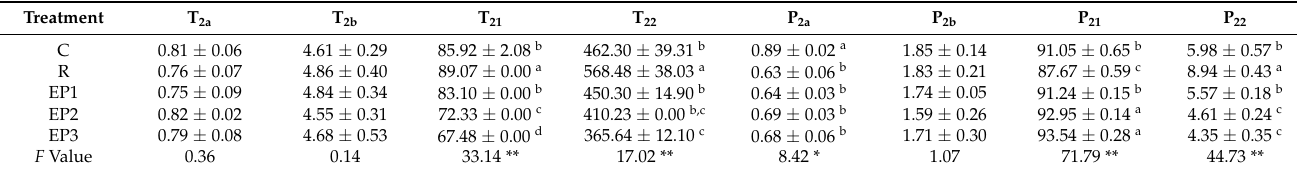
Table 5. T 2 relaxation time and corresponding population of sausages.